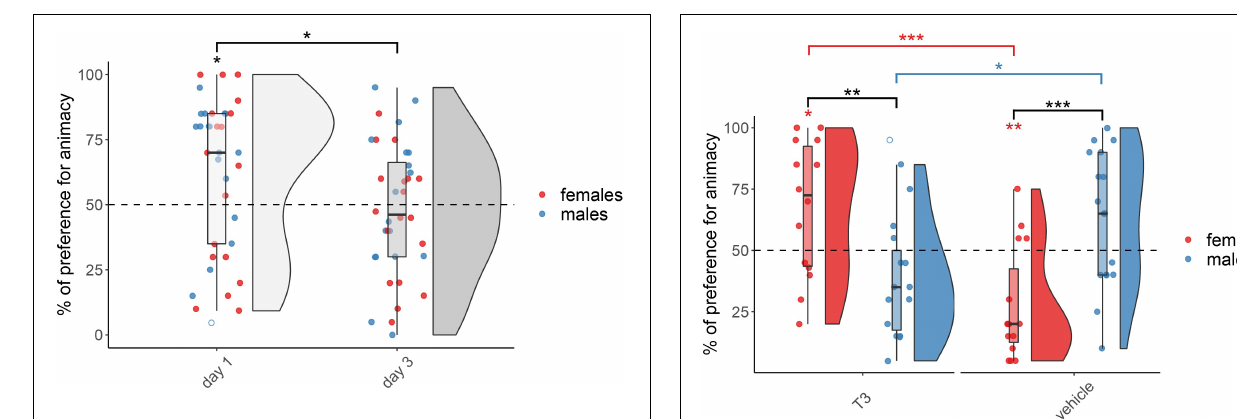
FIGURE 1 | Preference for animacy for the not-injected chicks tested 1 or 3 days after hatching. To best represent the data, we used raincloud plots. Asterisks indicate significant differences from chance (black dotted line). Black asterisk between the two groups indicates a significant difference between testing Days. * indicates p < 0.05. Filled red dots represent female and blue male subjects, empty dots represent outliers, which were removed from the analyses.